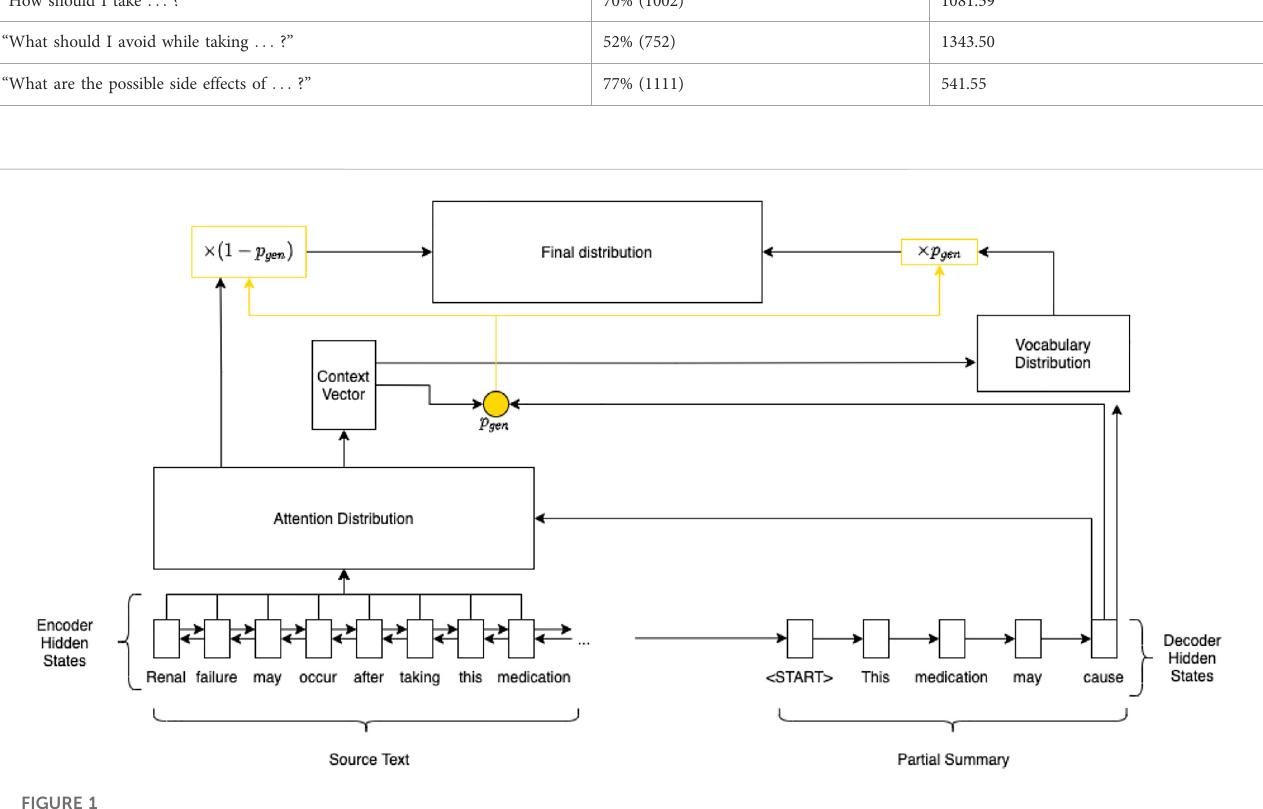
FIGURE 1 Pointer-generator